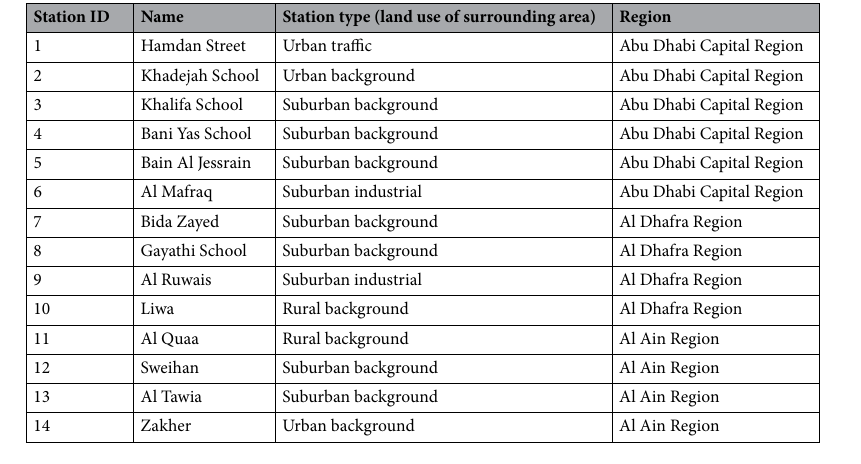
Table 1. Ground station network in the Abu Dhabi, Al Dhafra, and Al Ain